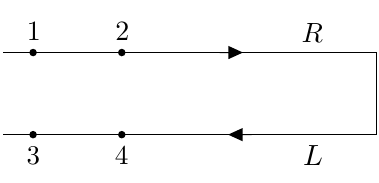
T [ (cid:30) 3 (cid:30) 4 ] T [ (cid:30) 1 (cid:30) 2 ] . The arrows indicate the (cid:13)ow of time h i